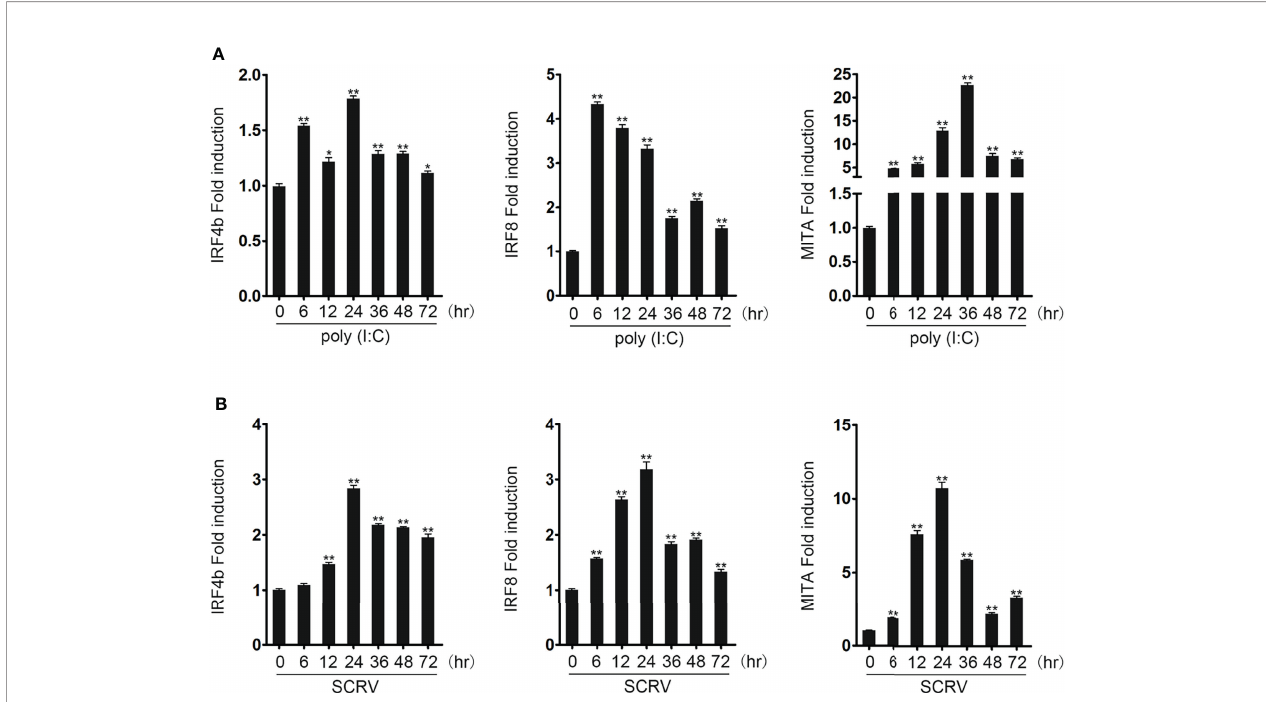
FIGURE 1 | IRF4b and IRF8 are upregulated after poly(I:C) and SCRV induction. The expression patterns of IRF4b, IRF8, and MITA were analyzed using the liver samples of fi sh obtained at 0, 6, 12, 24, 36, 48, and 72 h after being injected with poly(I:C) (A) and SCRV (B) by qRT-PCR, respectively. * p < 0.05; ** p < 0.01. All the experiments were performed independently at least three